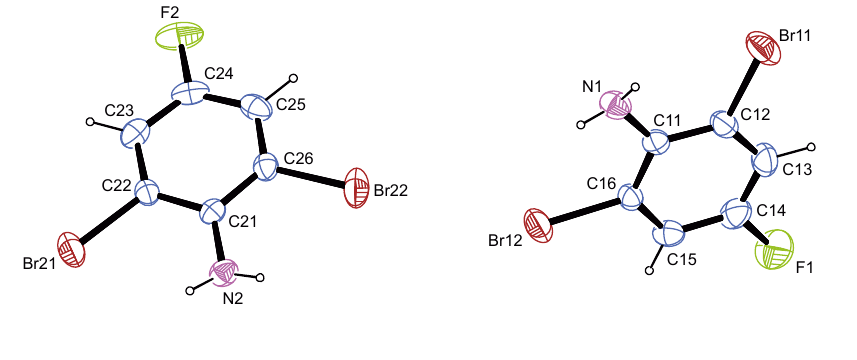
Table  : Data collection and